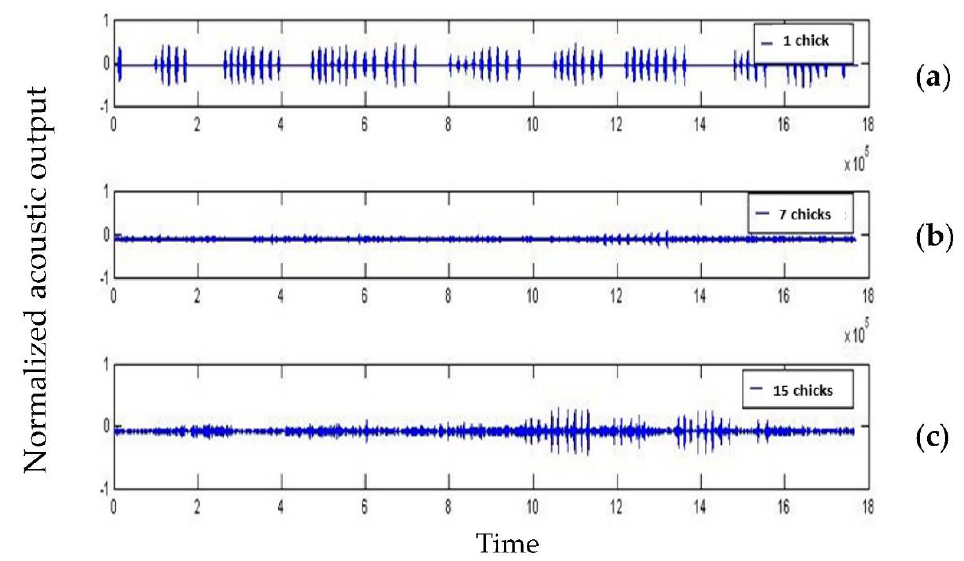
Figure 3. Vocalization spectral output of 1 chick ( a ) and in a group of 7 ( b ) and 15 ( c ) chicks in the time domain. 0 = baseline; normalized acoustic output varies from −1 to 1). Table 1. The normalized mean of a 1-day-old chick’s weight and energy expenditure during vocal- ization in a group and alone.